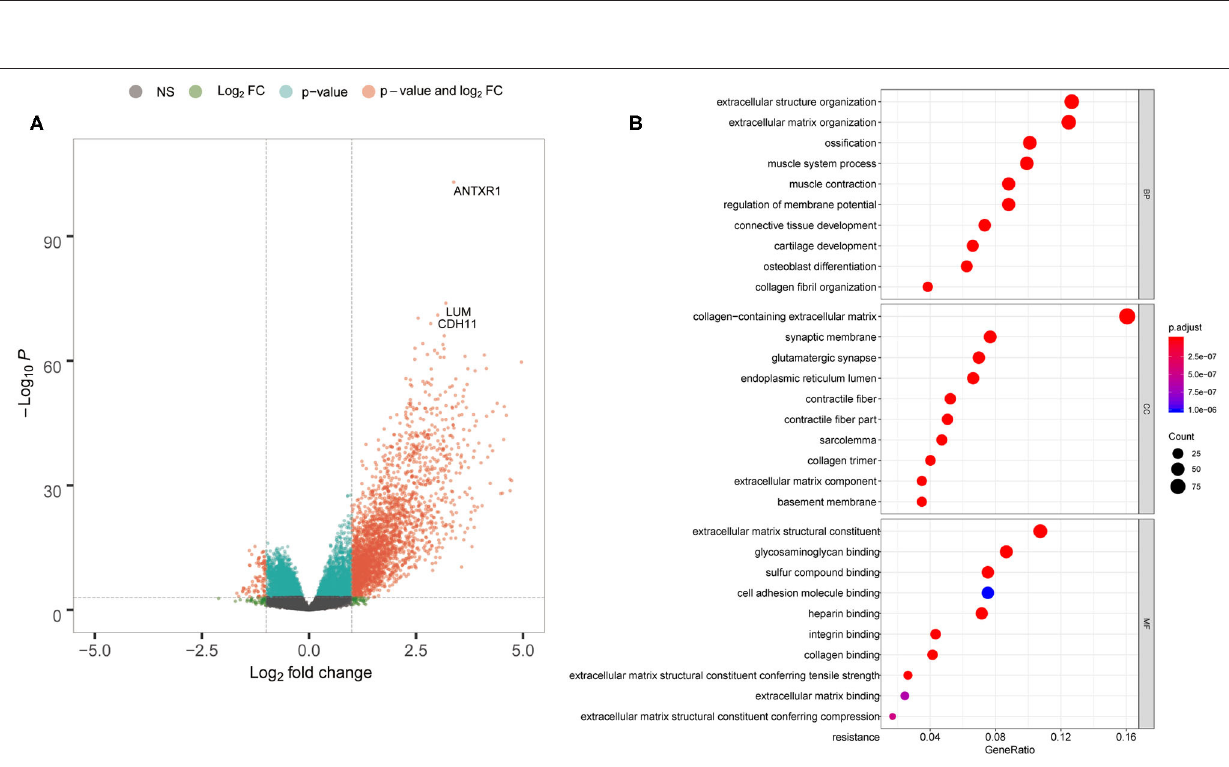
Frontiers in Molecular Biosciences |